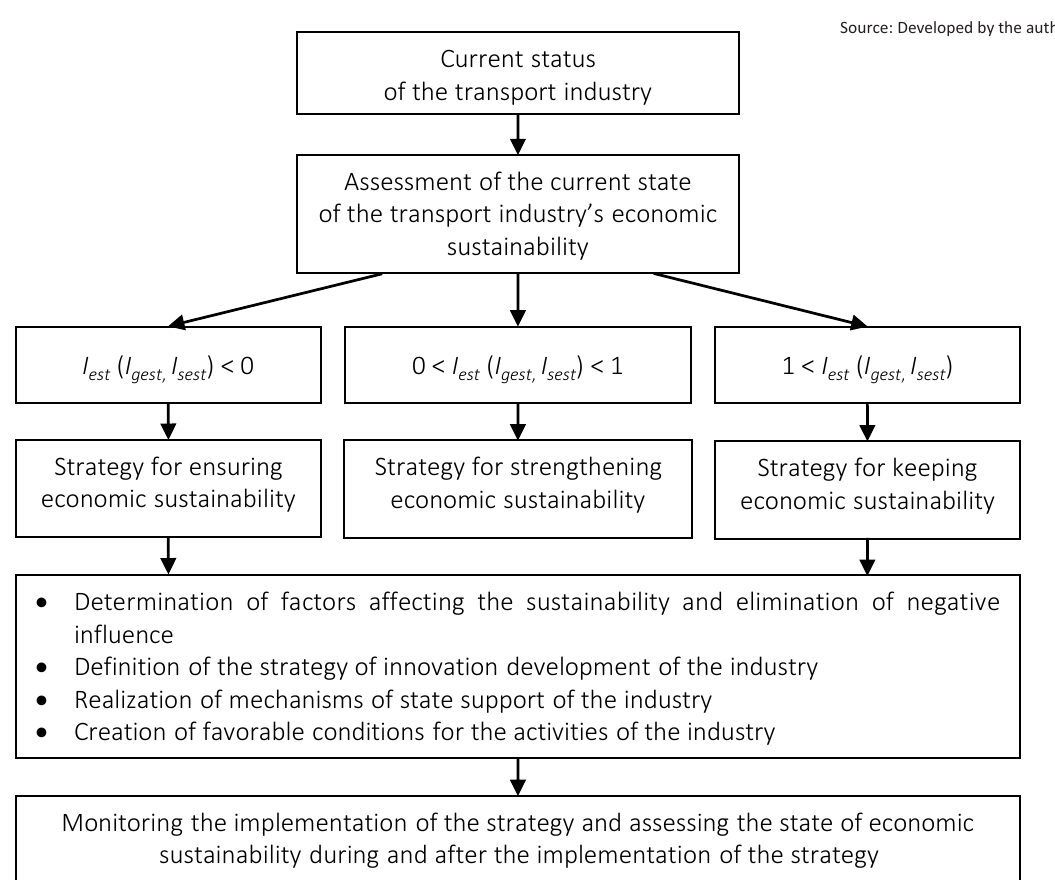
Figure 7. Structural-logical scheme of ensuring the economic stability of the transport